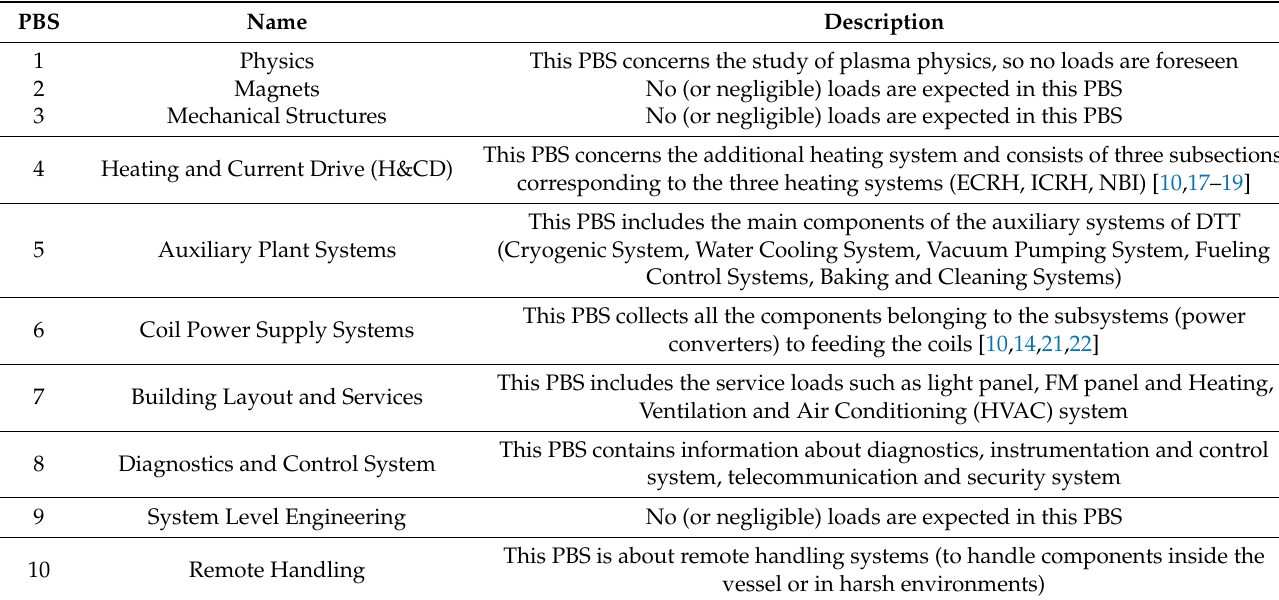
Table 1. PBS organization and